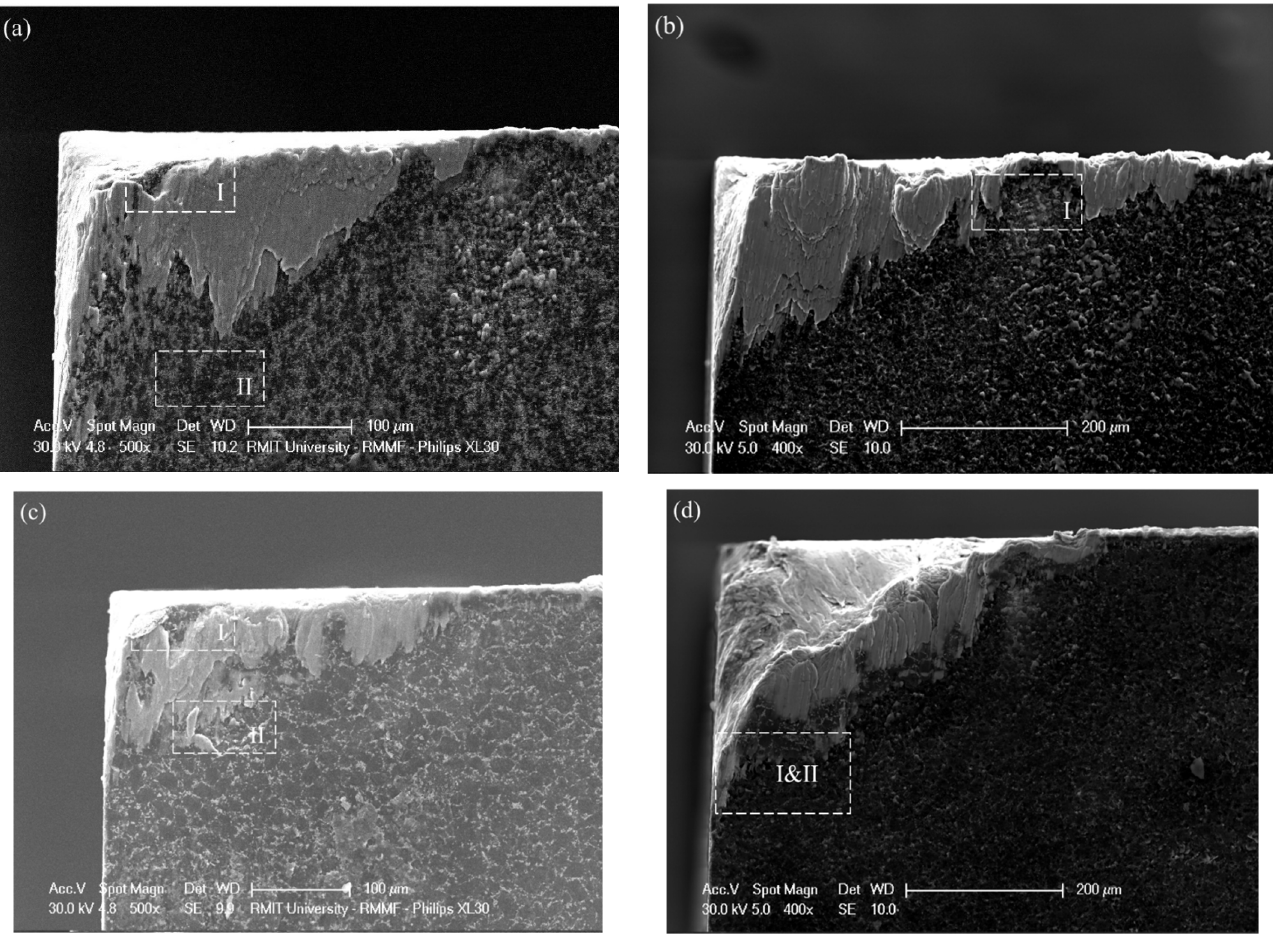
Figure 9. Micro-morphology of the flank wear on the four PCD inserts: ( a ) 002A, ( b ) 002E, ( c ) 302A, and ( d ) 302E.